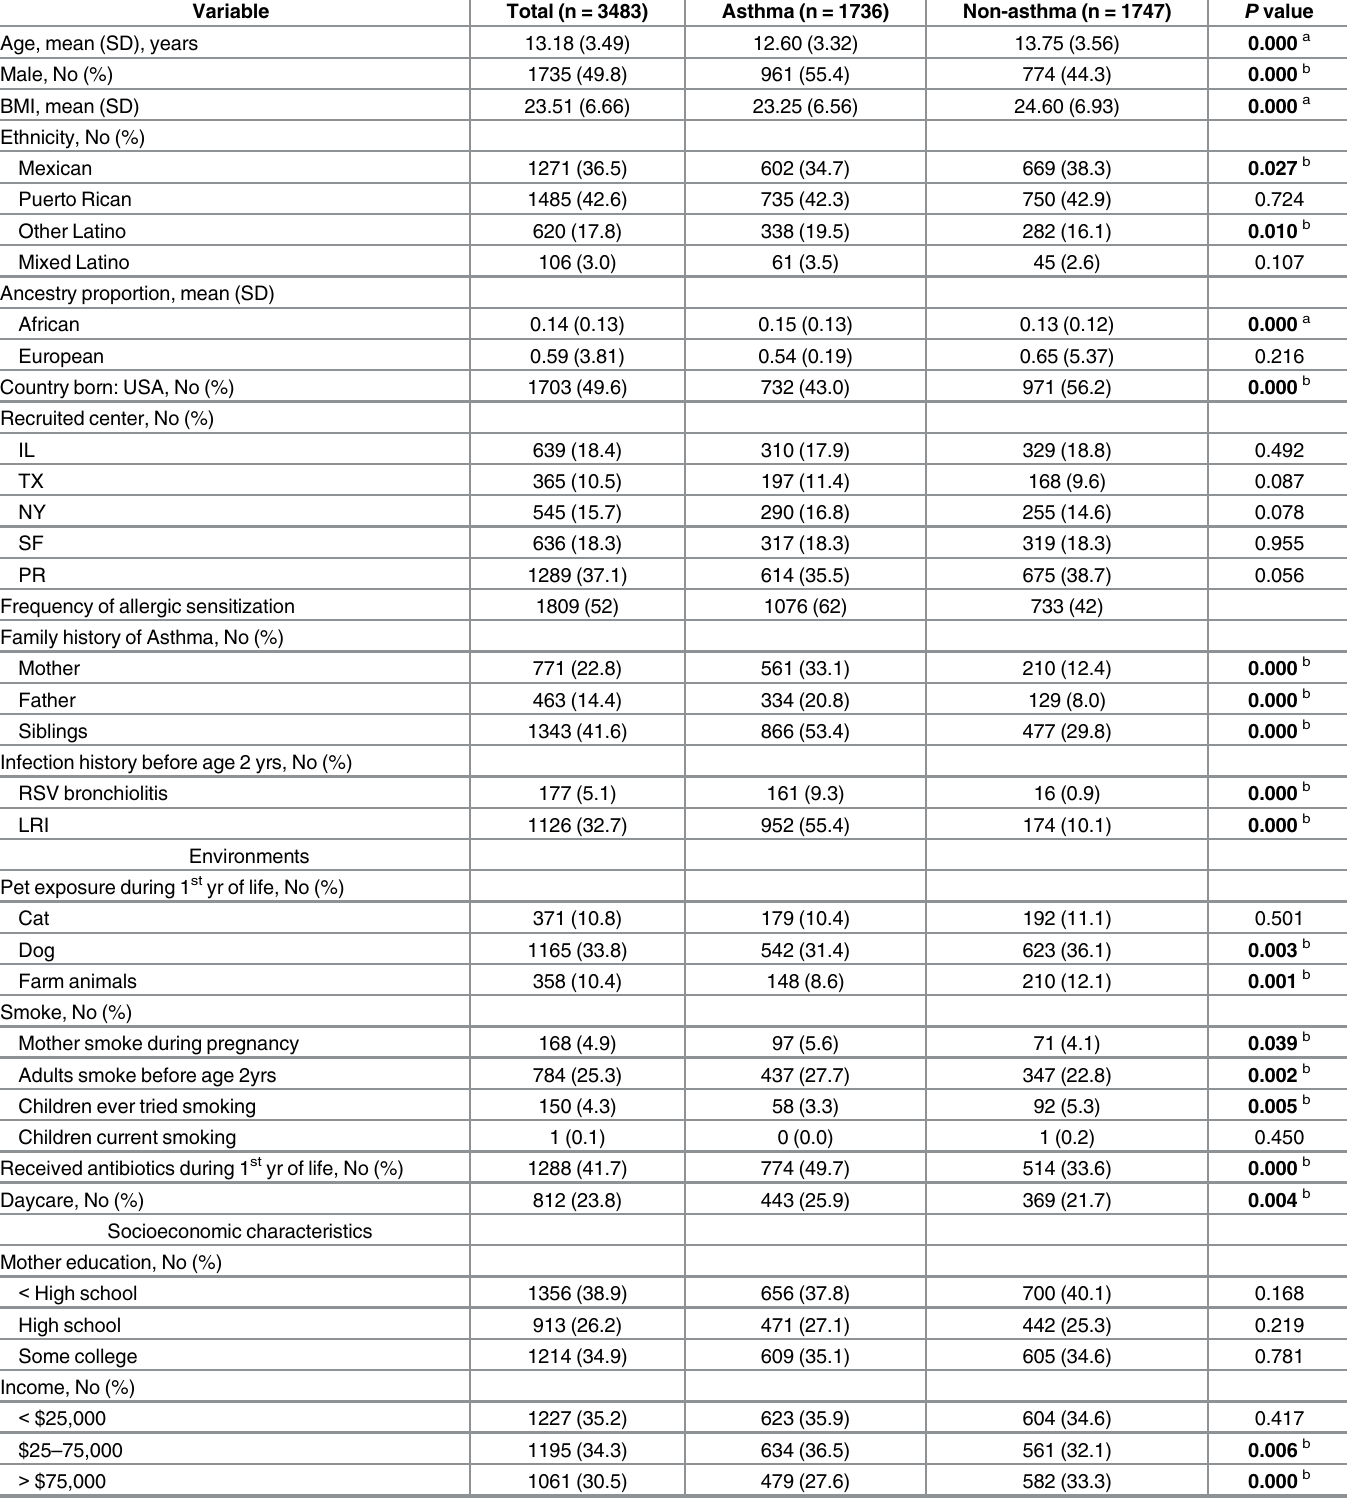
Table 1. Demographic and clinical characteristics of